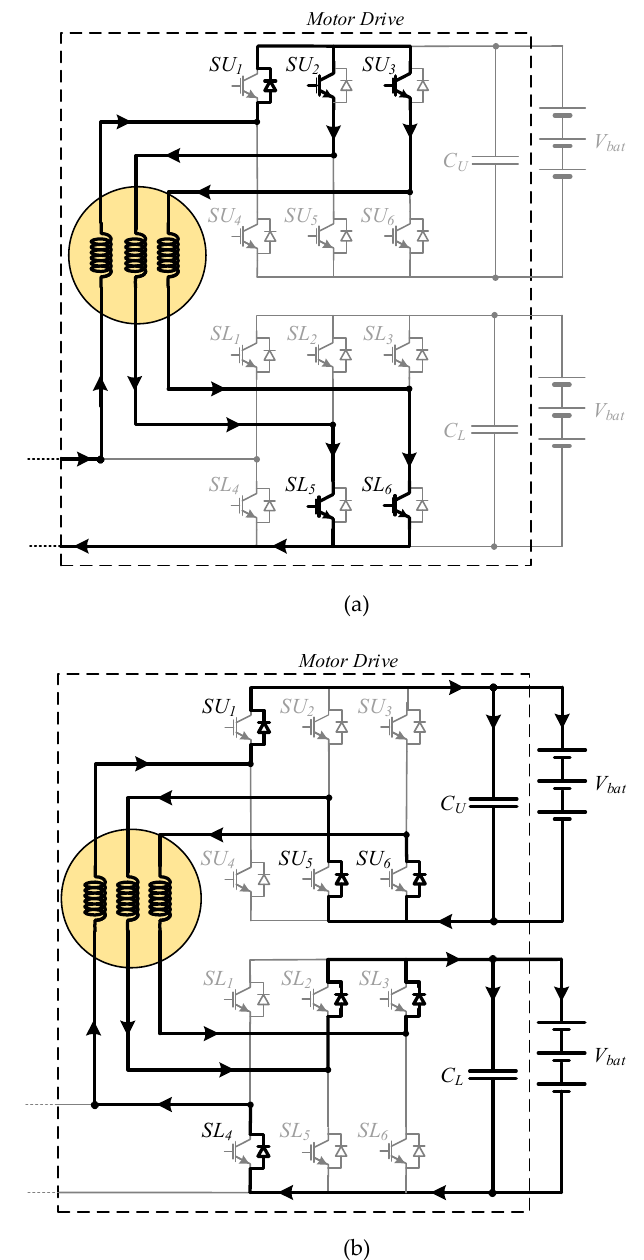
Figure 3. Modes of the motor drive: ( a ) mode 1; ( b ) mode 2 during the charging operation.